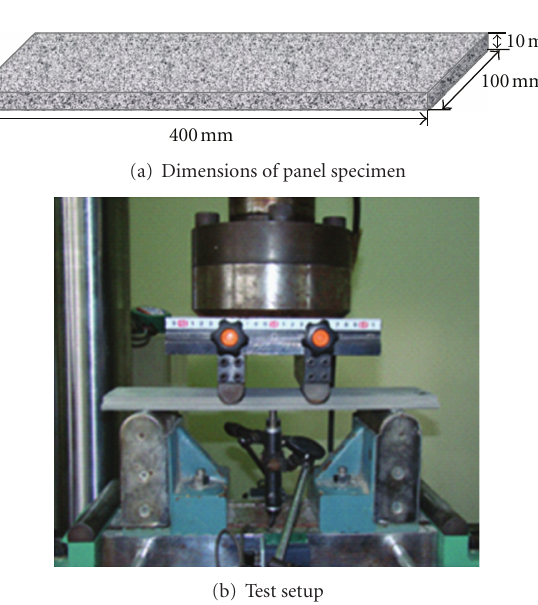
Figure 3: Bending test of extruded DFRCC panel.